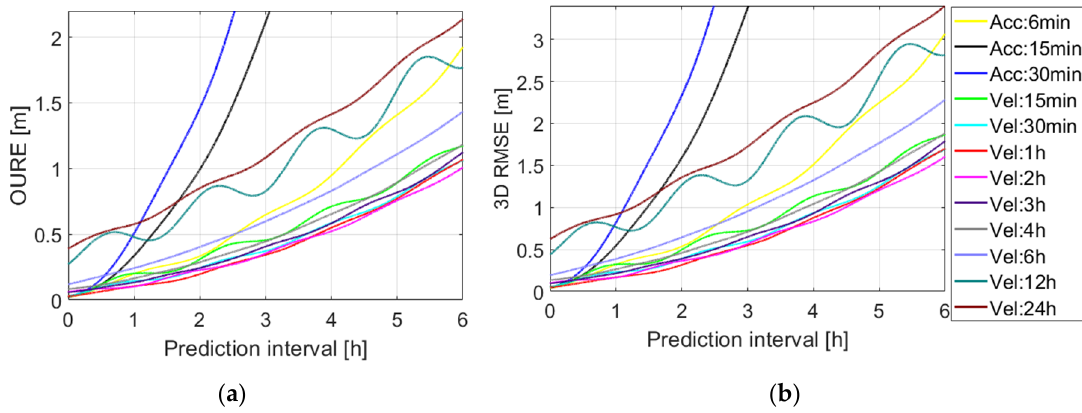
Figure 8. ( a ) The orbital user range error (OURE) and ( b ) the 3D root mean square error (RMSE) of the predicted orbits applying different dynamic models (Table 2).